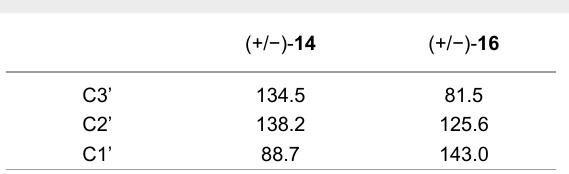
Table 1: Selected chemical shifts in 13 C NMR. a